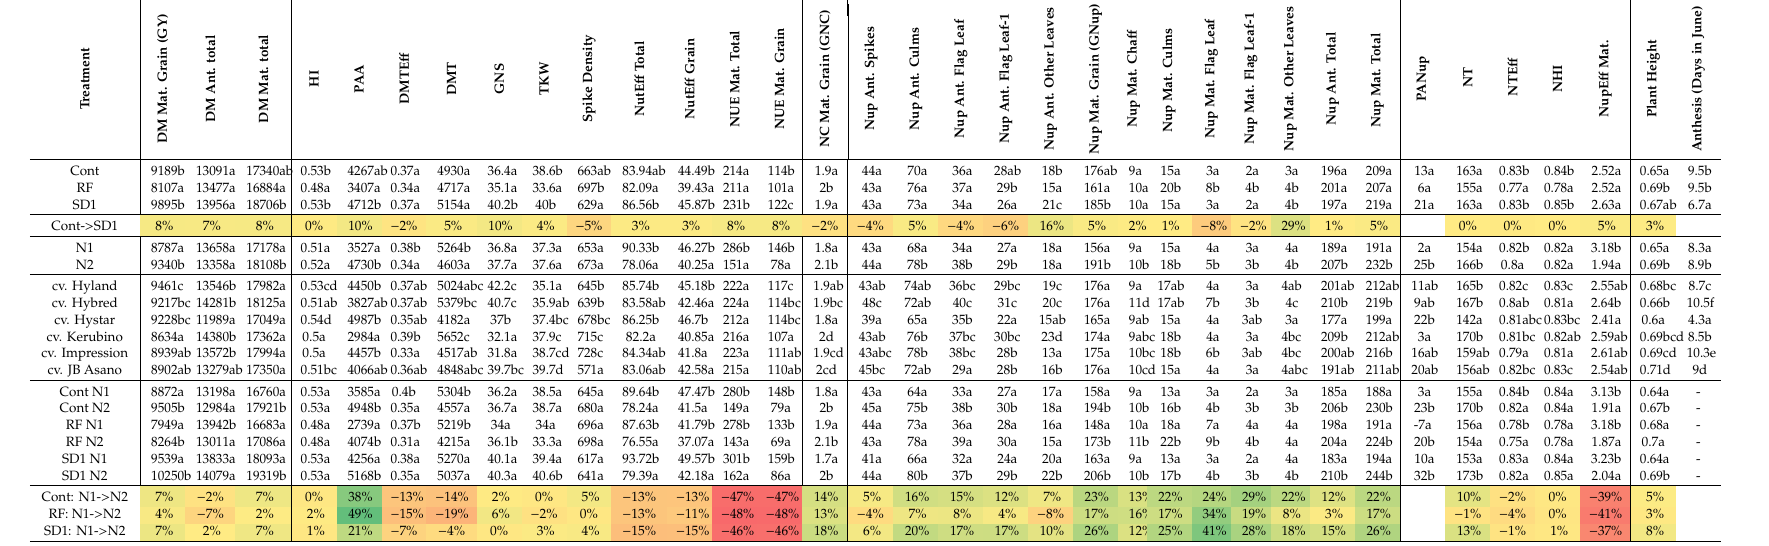
Table 5. Estimated marginal mean values and grouping letters of Tukey’s post-hoc-test by treatment factors for selected traits. See Equation (1) for the relationship of traits within trait complexes. Cells colored from red (strong negative reaction) to green (strong positive reaction) indicate the relative response in the trait value between Cont and RF and between Cont and SD1 as the main plot e ff ects and between N1 and N2 within the main plots. PANup was not included for coloring due to extreme relative responses, however on low levels only. For the anthesis date, independent data was lacking for statistics within the main